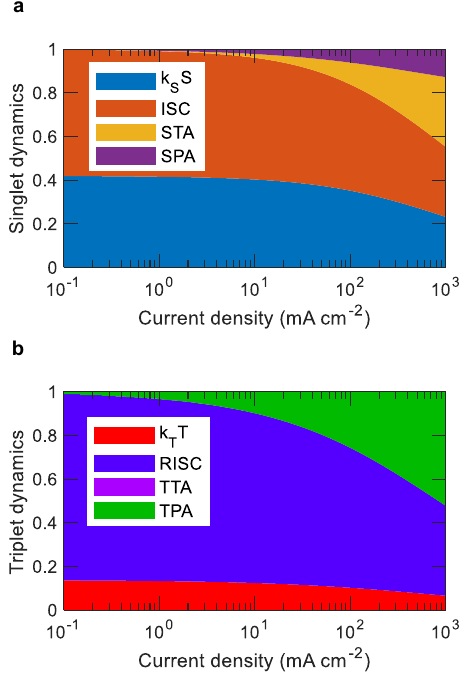
Fig. 4 Relative contributions of the different excitonic processes associated with TADF emission. Relative contributions are plotted for mCP:4CzIPN OLEDs as a function of current density. a Deactivation of singlet excited state. b Deactivation of triplet excited